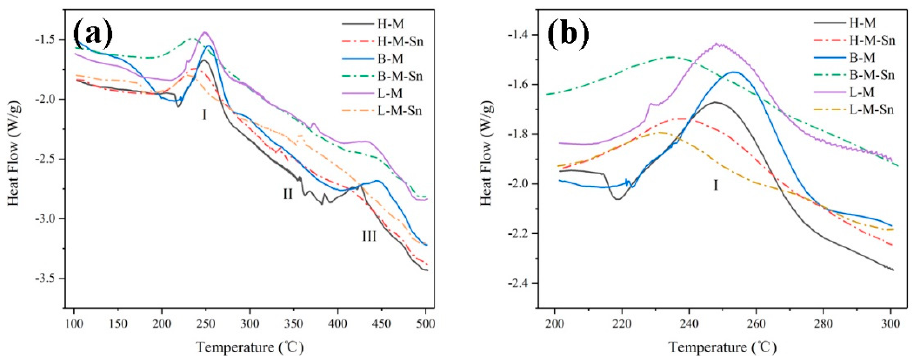
Figure 6. Differential scanning calorimeter (DSC) heat flow curves of six investigated alloys: ( a ) as-quenched, ( b ) precipitation peak of β″ precipitates.